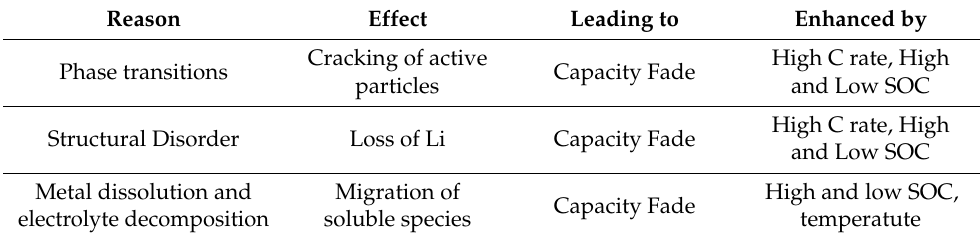
Table 5. Effects on positive